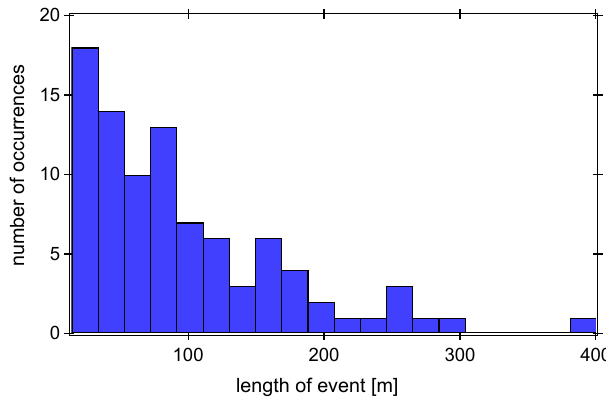
Figure 4. Frequency distribution of the horizontal extent of the ob- served 91 new particle formation